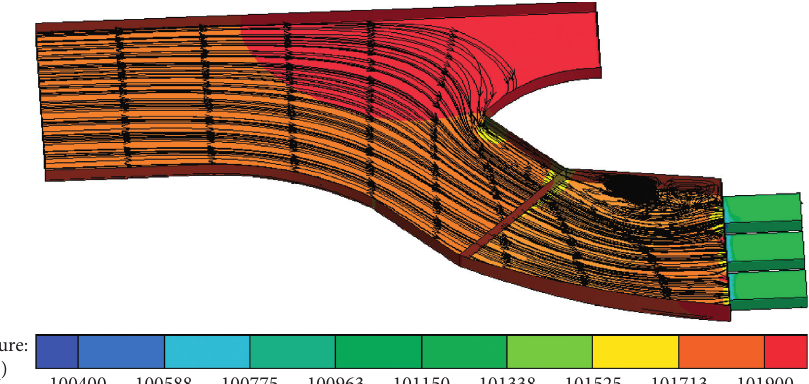
Figure 5: 3D flow field diagram of the lateral 45 ° bending angle